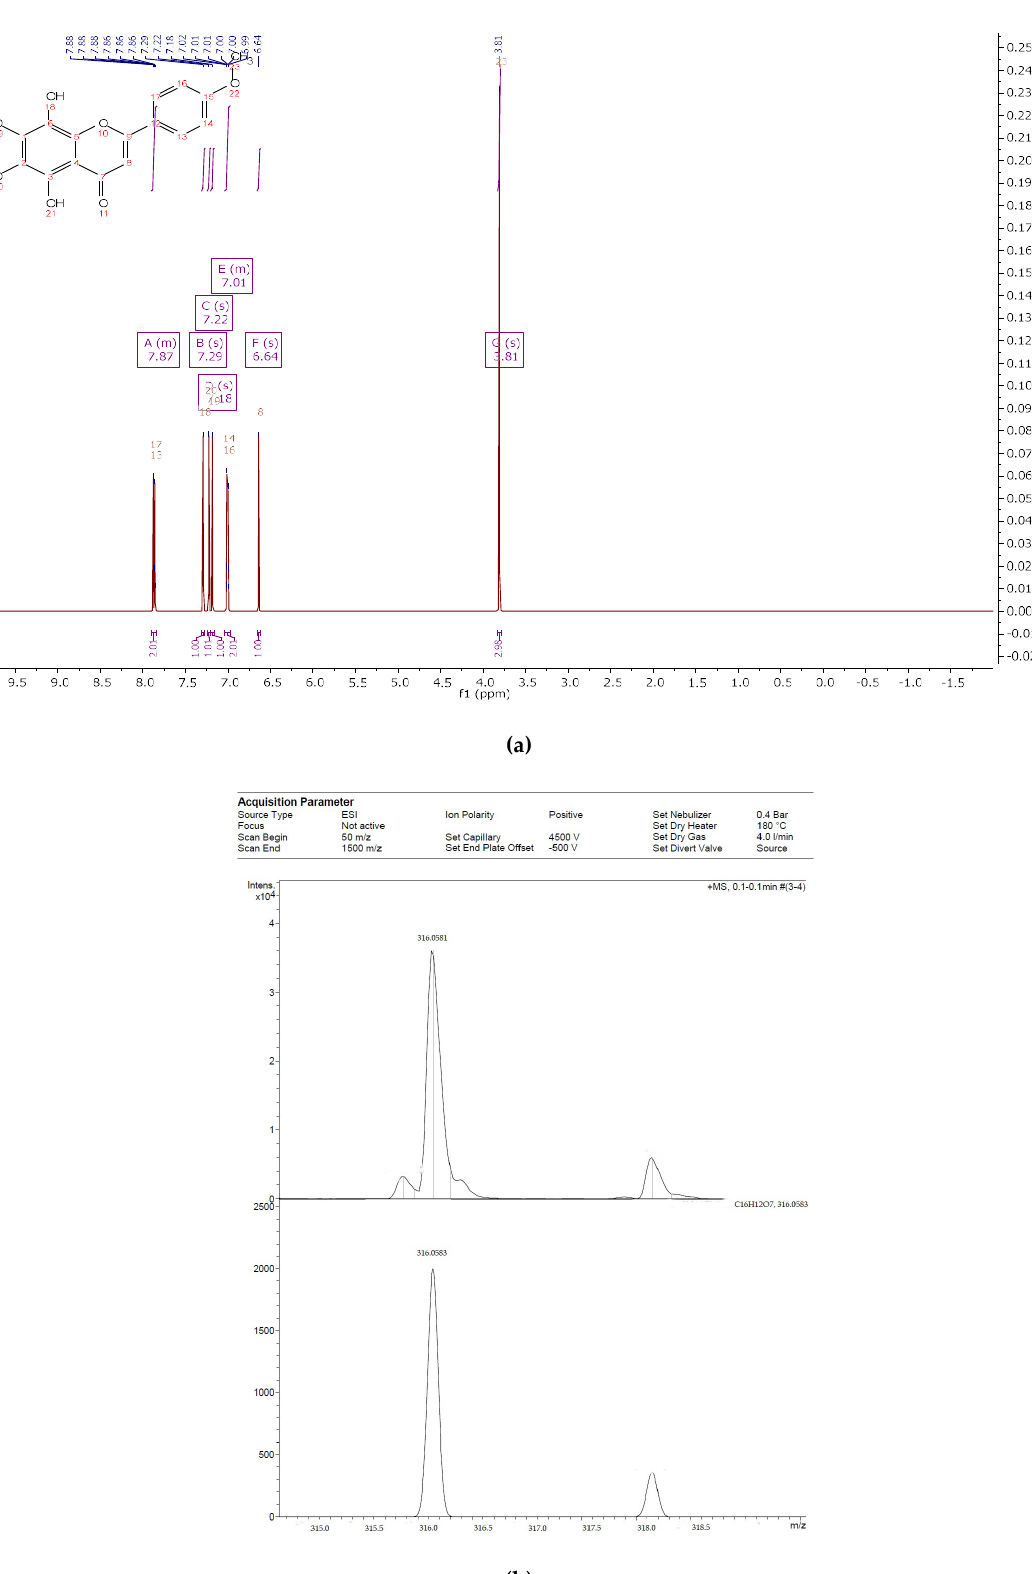
Figure 6. 1 H NMR ( a ) and HRMS ( b ) spectrum of 5,6,7,8-tetrahydroxy-4-methoxyflavone from extracts of callus, cell suspension, and root cultures of Rhodiola rosea